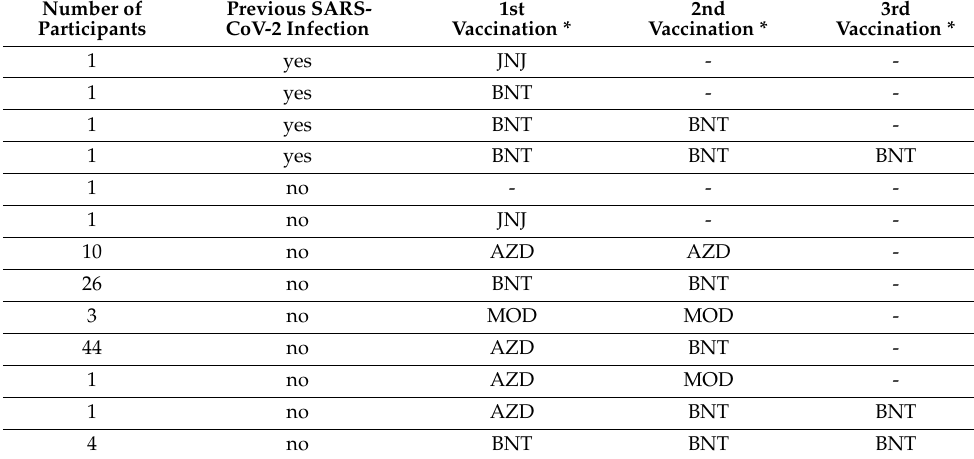
Table 2. Vaccination status of participants.